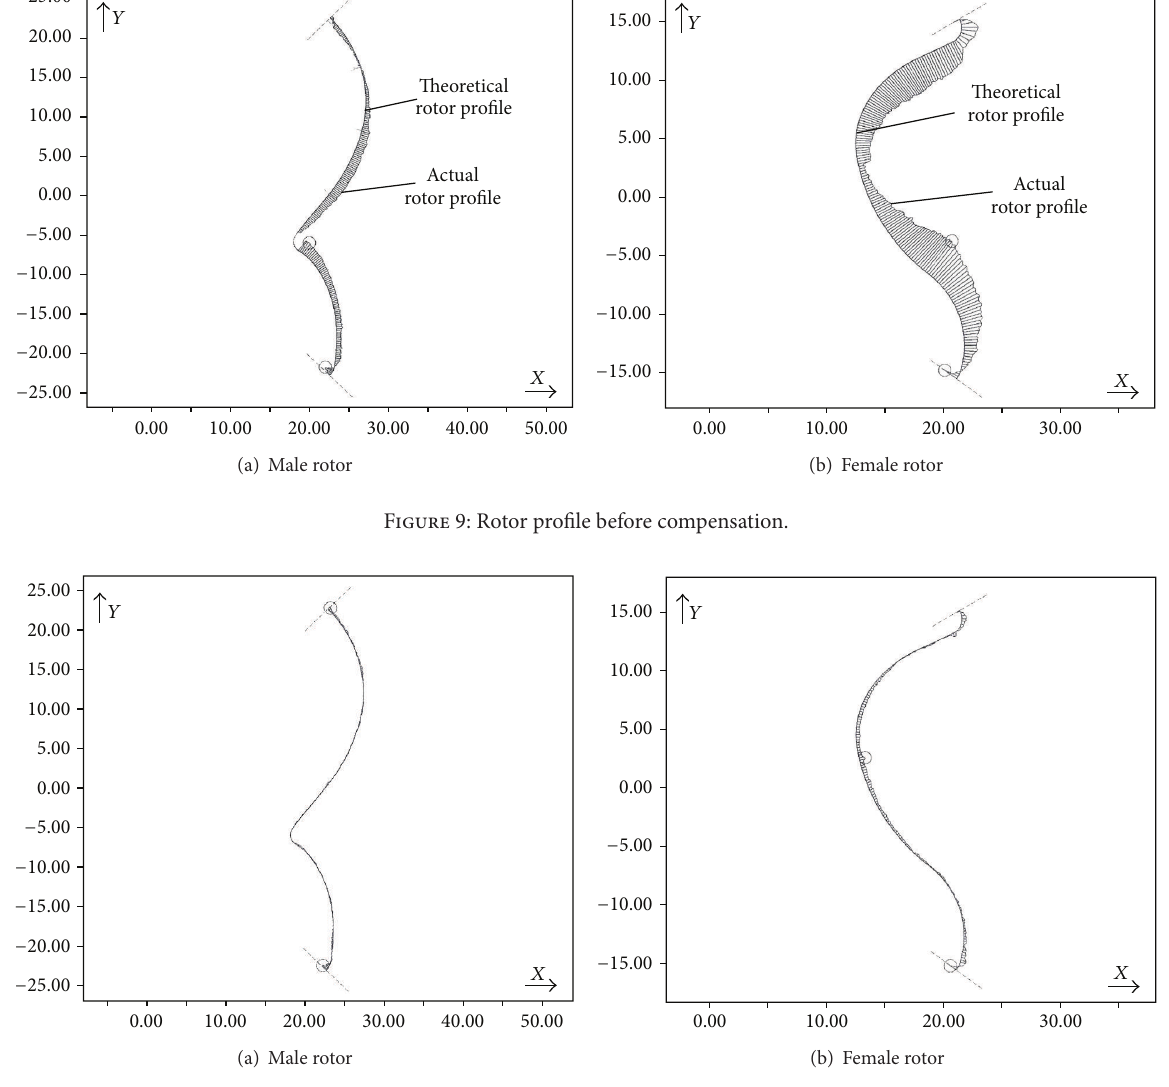
Figure 10: Rotor profile after compensation.